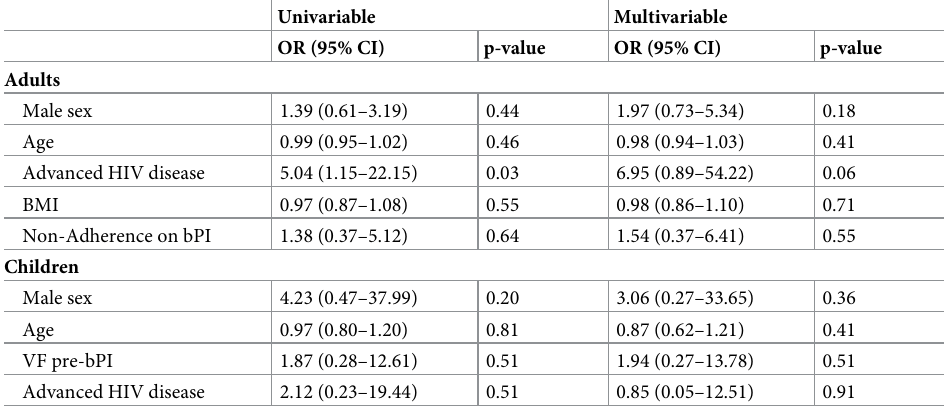
Table 4. Risk factor analysis for virologic failure at 6–12 months on boosted protease inhibitor. Univariable Multivariable OR (95% CI)